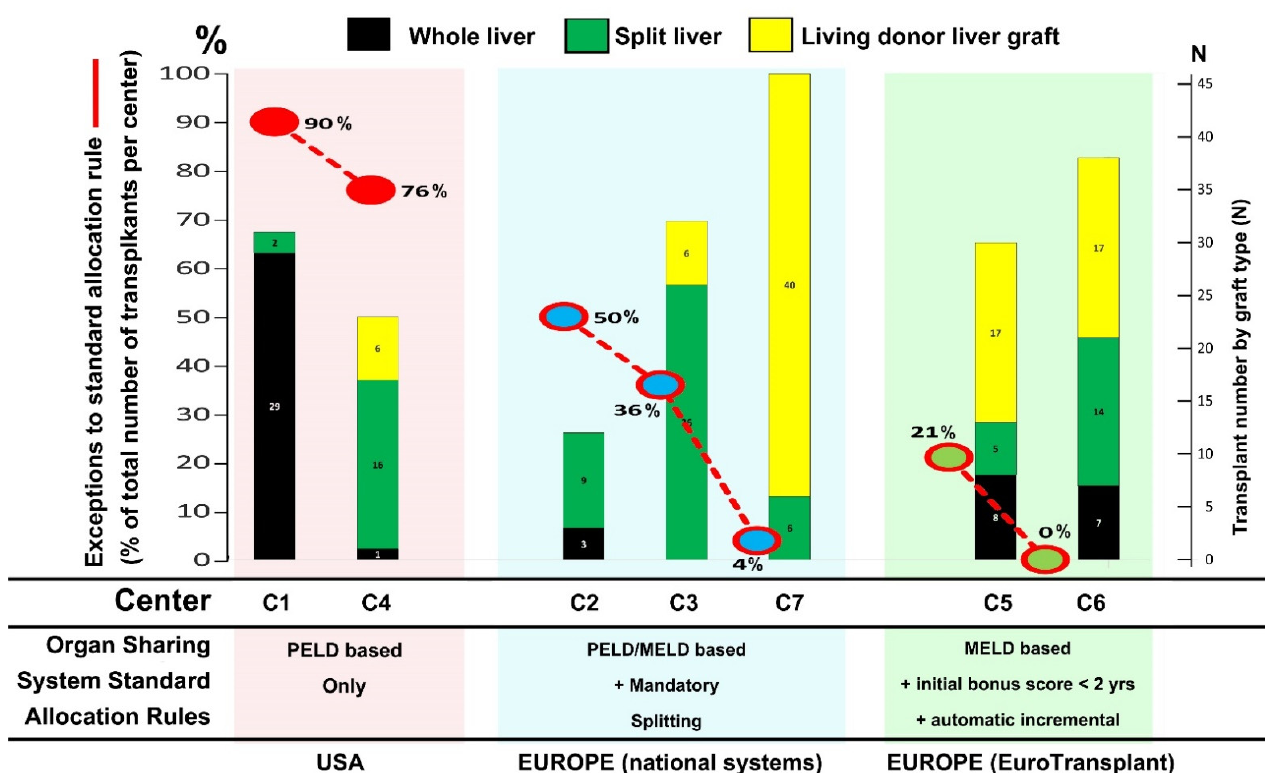
Figure 3. Use of PELD exception or priority status for biliary atresia patients registered on the waiting list before age 3 years, according to the type of allocation rules and types of organ used. Transplant data from 7 centers. 1—Proportion of transplants performed under PELD exception or priority status (red line) (values in % in each transplant), and 2—number of transplants and graft types used: whole livers (black), split livers (green) and living donor grafts (yellow). Centers (defined as in Figure 1) are aligned left to right according to their affiliation to one of 3 allocation systems that differ about allocation rules for small children (see legend on the bottom).